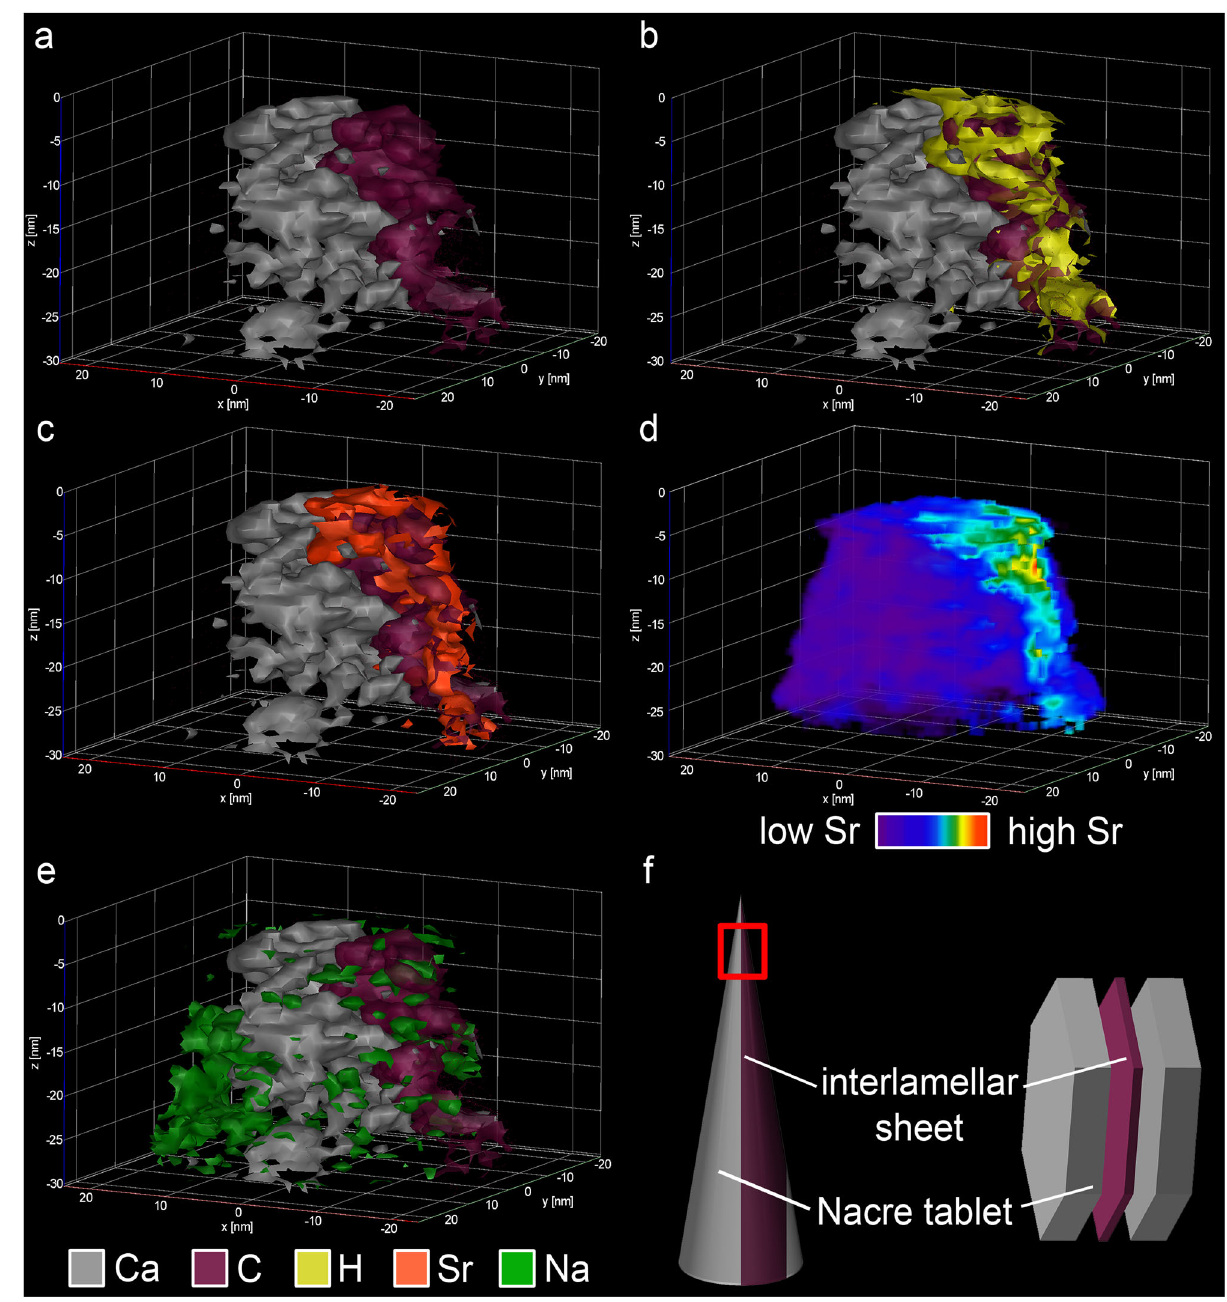
Fig. 3 | 3D APT reconstruction showing parts of the nacre tablet and the organic interlamellar sheet in Sr-labelled nacre (specimen: M2S2R). a Iso- concentration surfaces of Ca (50 at%, grey) depicting the outer area of a nacre tablet and elevated C (5.1 at%, magenta) identi fi es the organic interlamellar sheet. b Iso-concentration surfaces of H (10 at%, yellow) co-located with high C con- centrationsintheorganicinterlamellarsheet. c Theiso-concentrationsurfaceofSr (20at%,red)showsadistinctSr-richareasituatedbetweenSr-pooraragonitewithin